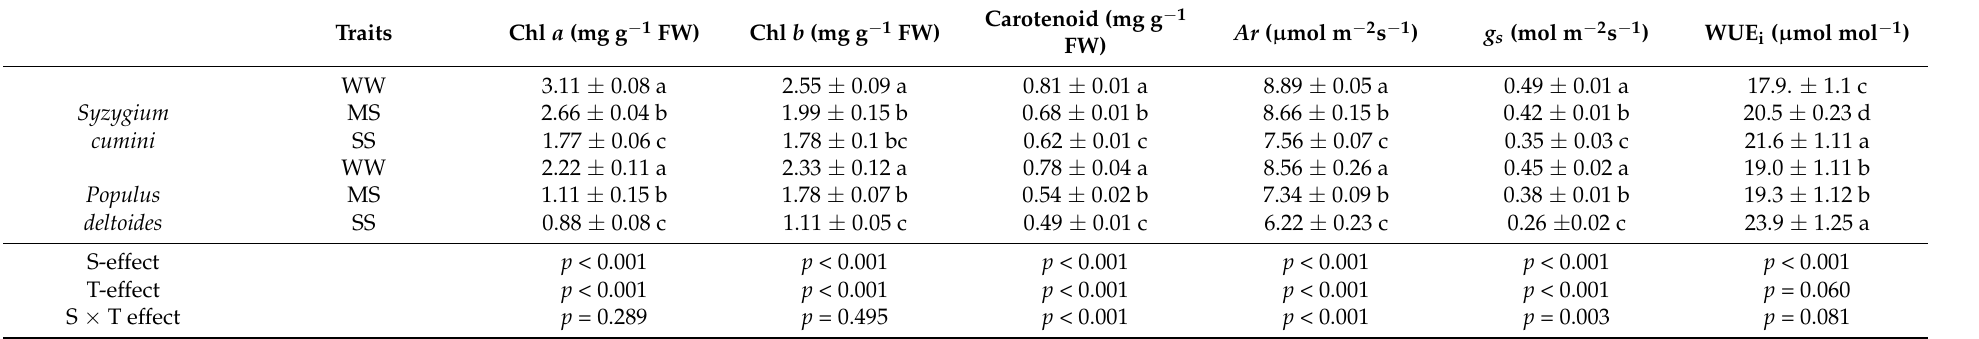
Table 2. Chlorophyll a, b , carotenoid contents and gas exchange parameters (CO 2 assimilation rate ( Ar ), stomatal conductance (g s ) and water use efficiency (WUE i )) under various level of water deficit treatments in Syzygium cumini and Populus deltoides . The traits were tested using a two-way ANOVA for species effect (S-effects), treatment effect (T-effects) and interaction effects (S × T). Values represent the means ( ± SE) in various treatments. Small letters represent significant difference between treatments within each species tested using the Dunnett’s test. All tests were taken to be significant at p <